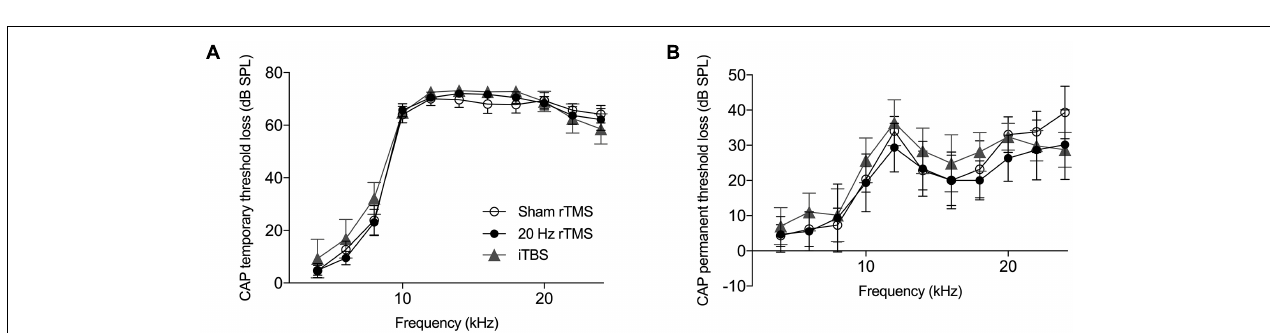
FIGURE 4 | Hearing threshold loss following acoustic trauma. Mean compound action potential threshold loss in the left ear. (A) Average CAP threshold loss measured at multiple frequencies (4–24 kHz) immediately following exposure to acoustic trauma. (B) Average CAP threshold loss at multiple frequencies (4–24 kHz) at the day of final electrophysiological recordings. All data mean ± SEM. No significant differences between groups